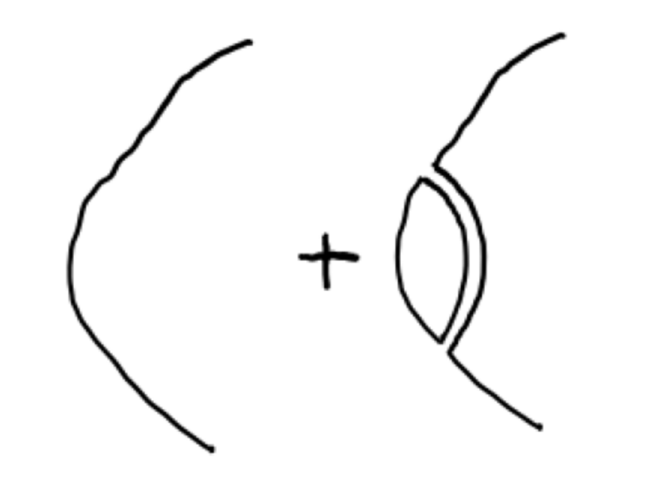
Figure 1 . The Feynman diagrams contributing to the corrections to the amplitude that are quoted in equation (2.16) are depicted in fat graph notation. The single lines represents the fundamental representation heavy quark and the double line represents the adjoint representation scalar and vector